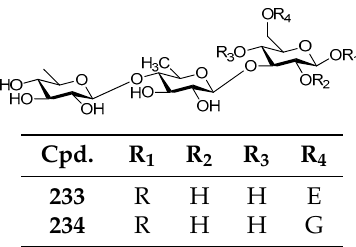
Figure 44. Structures of compounds 231 – 232 .